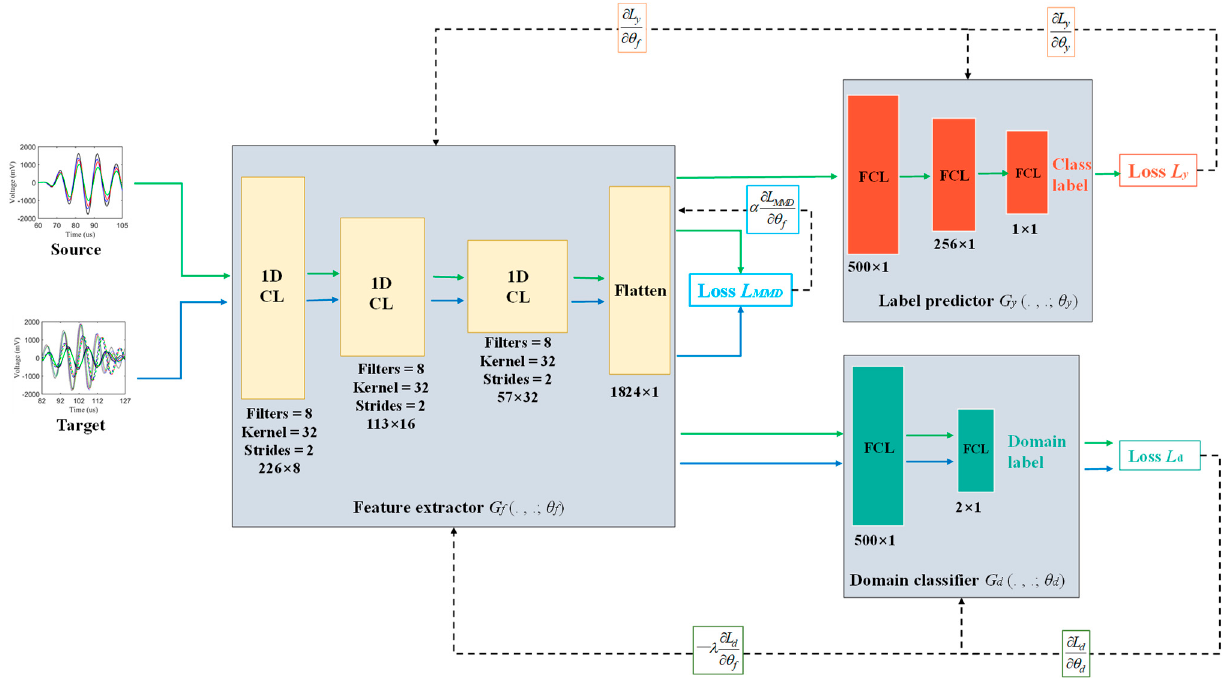
Figure 1. The architecture of the proposed MMD-DNN model.